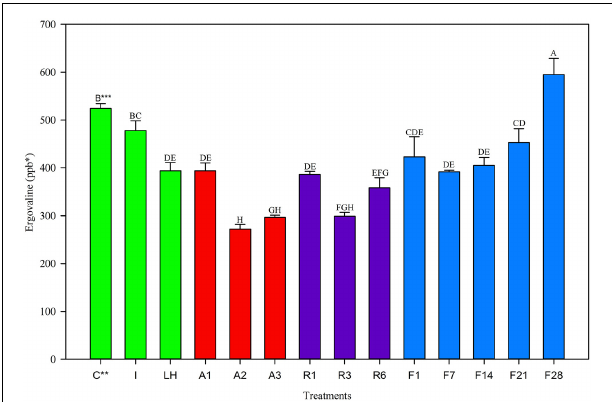
FIGURE 3 | Ergovaline concentration of all tall fescue sub-samples in various storage conditions from June 2013 harvest. ∗ Parts per billion. ∗∗ Treatment abbreviations are as follows: C, Control; I, Ice; LH, Light + Heat; A1, Ambient Day 1; A2, Ambient Day 2; A3, Ambient Day 3; R1, Refrigerator Day 1; R3, Refrigerator Day 3; R6, Refrigerator Day 6; F1, Freezer Day 1; F7, Freezer Day 7; F14, Freezer Day 14; F21, Freezer Day 21; and F28, Freezer Day 28. ∗∗∗ Matching letters indicate no statistical difference at a significance level of P < 0 .